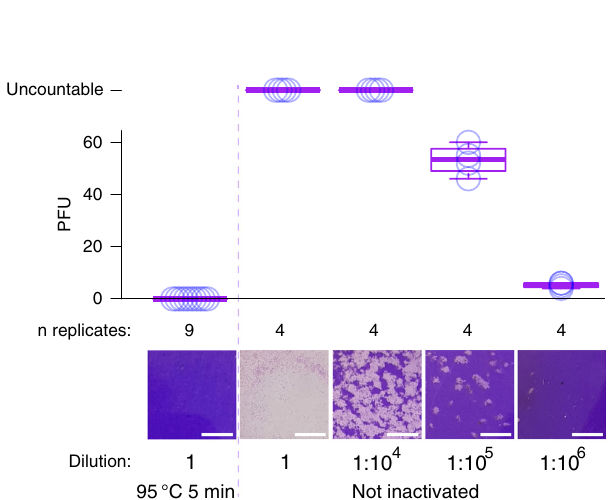
Fig. 4 Heat-inactivation of SARS-CoV-2 con fi rmed by plaque assay. Box plots showing the number of plaque forming units (PFU) observed after heat inactivation (95 °C 5 min, left) of in vitro propagated active SARS- CoV-2 as well as for a dilution series of SARS-CoV-2 without heat inactivation (right), with circles indicating the values of individual replicates. Center lines denote the median, hinges denote IQR and whiskers denote outlier points at maximum 1.5 × IQR. Virus was added to 9.6 cm 2 dishes seeded with 1 million Vero E6 cells and plaque assays were performed as described in “ Methods ” . Undiluted samples contained ~2.5 million PFU of SARS-CoV-2. Representative images are shown below each condition (scale bar 5